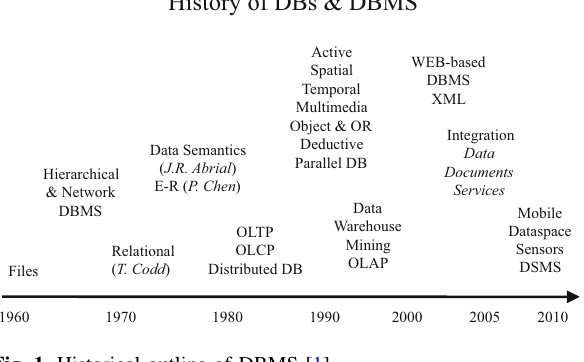
Fig. 1 Historical outline of DBMS [1]